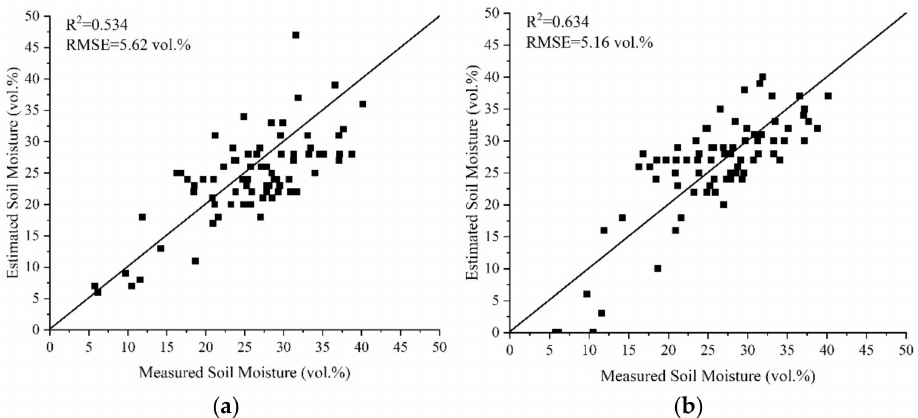
Figure 8. Scatter plot between measured and estimated soil moisture using F (3) based on effective surface scattering of VV and HH ( a ) CIEM; ( b ) Dubois models.